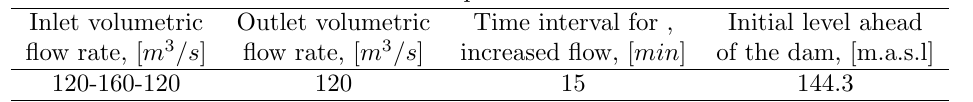
Inlet volumetric Outlet volumetric Time interval for , Initial level ahead flow rate, [ m 3 /s ] flow rate, [ m 3 /s ] increased flow, [ min ] of the dam, [m.a.s.l]